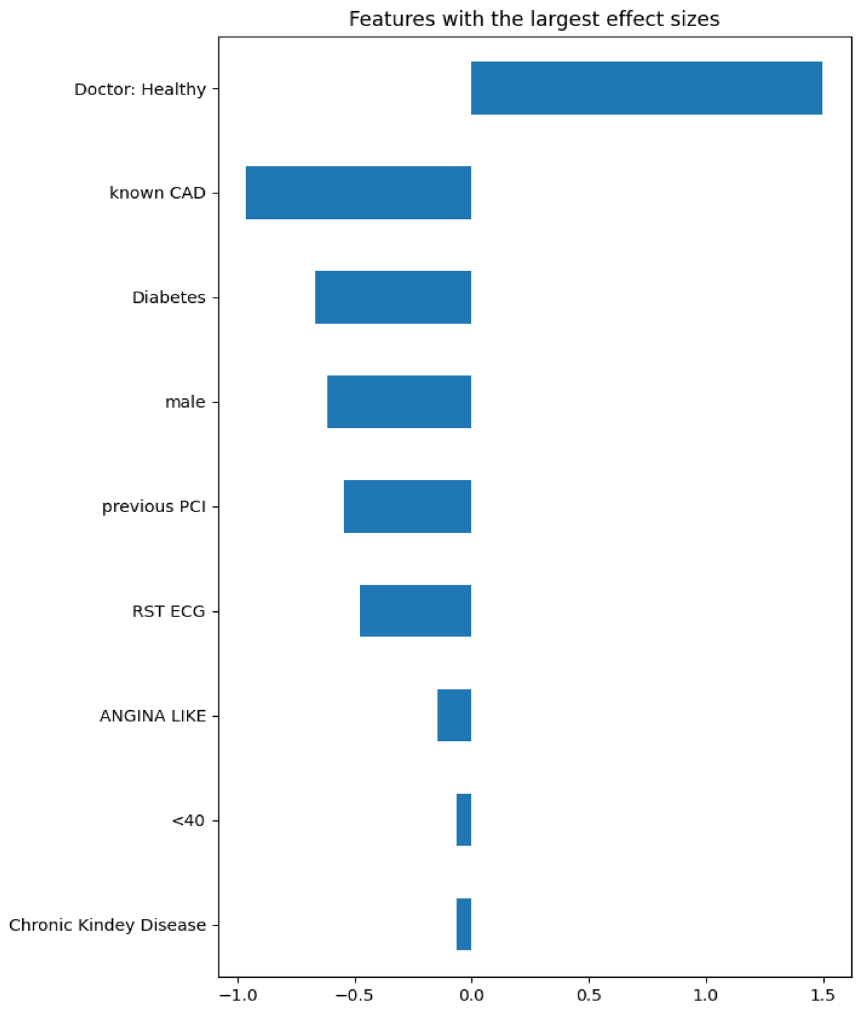
Figure 1. Cohen effect size for each input feature sorted by magnitude of